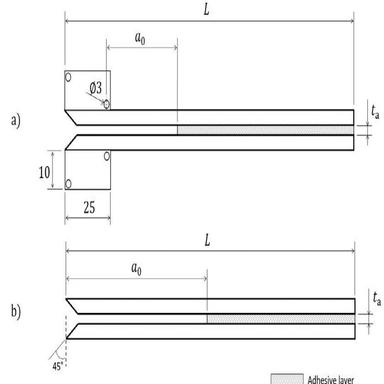
Specimens for (a) DCB tests and (b) WDT+. Dimensions in mm. ta is the bondline thickness. See values in and.